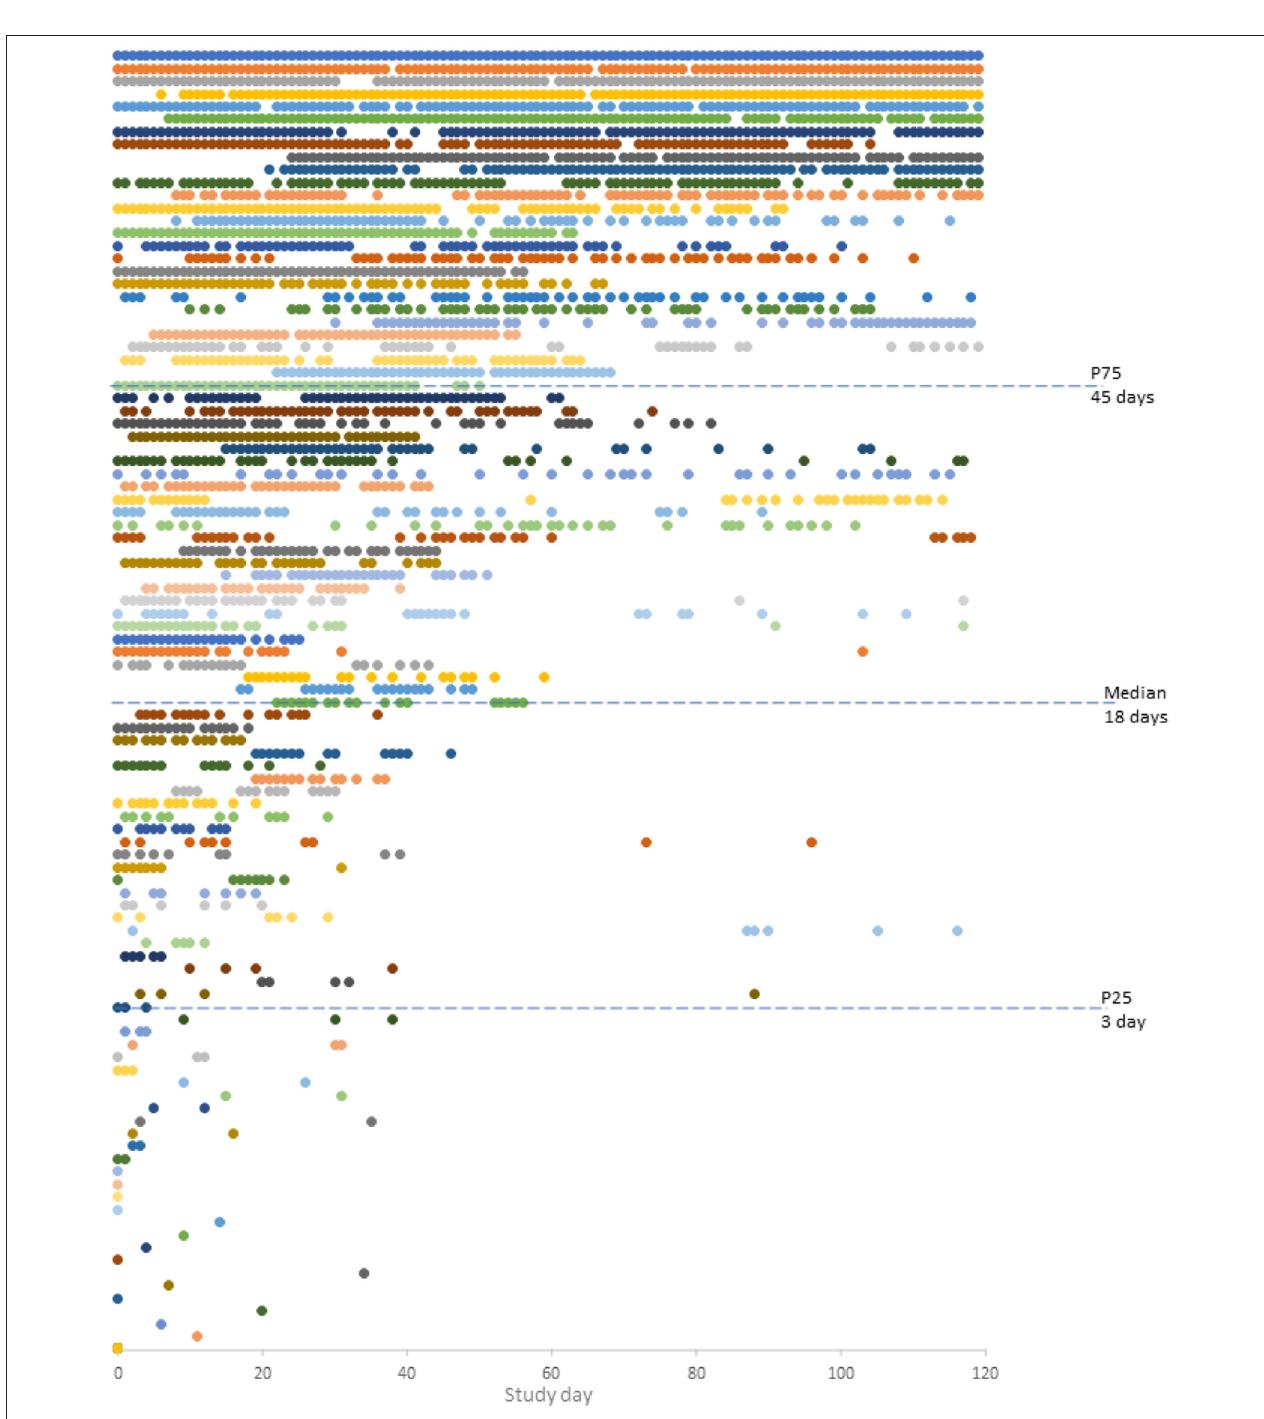
FIGURE 3 | Daily participant engagement with the InspirerMundi app during the 4 month ( n = 102, five users with missing information). Each circle represents a day with interaction(s) and each color represents each participant.